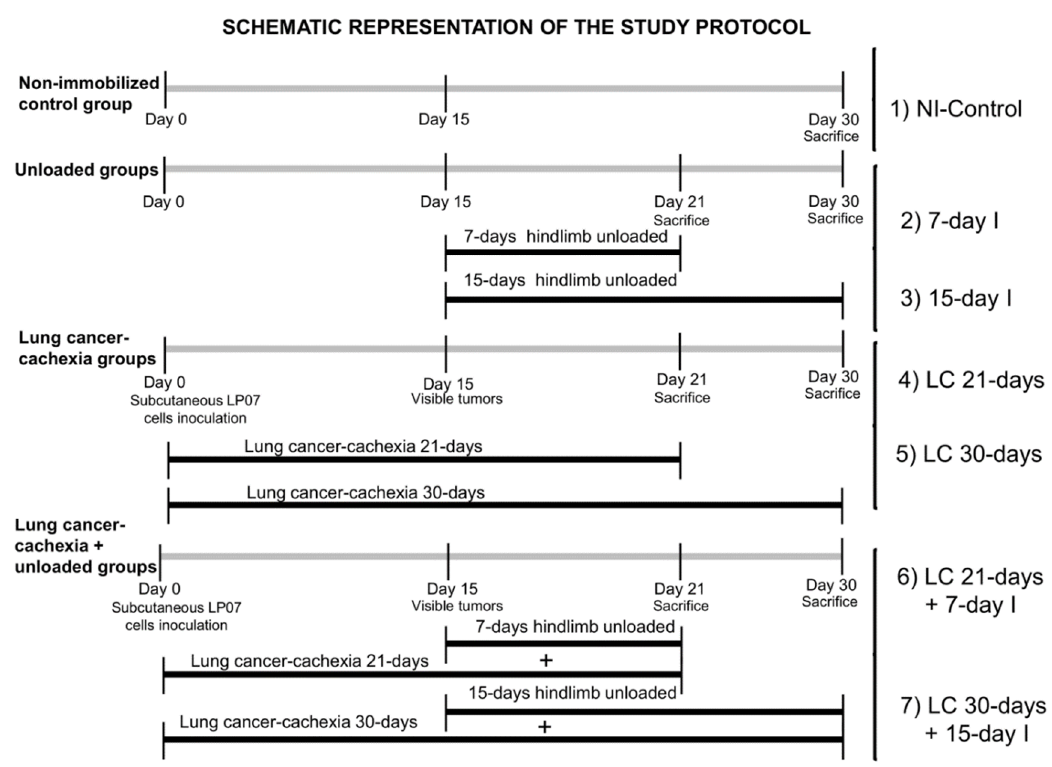
Figure 11. Graphical time-line representation of all the animal groups and the treatments administered to the mice in the study. Definition of abbreviations: NI, non-immobilized; I, immobilization; LC, lung cancer; MEM, minimum essential